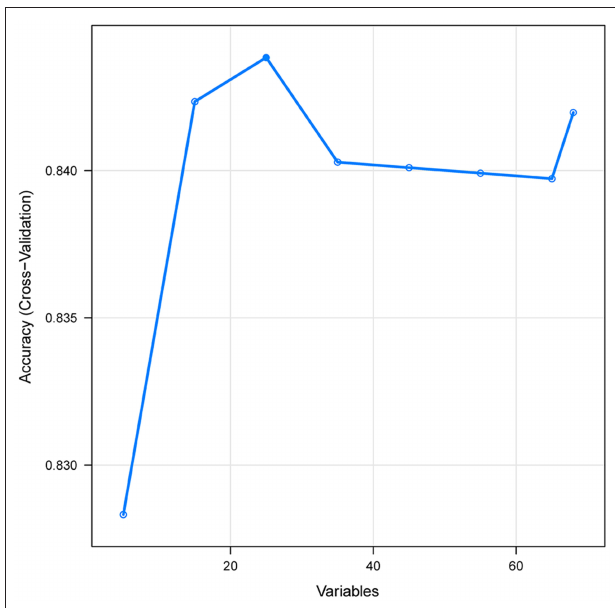
FIGURE 2 | Association between the numbers of variables allowed to be considered at each split and the prediction accuracy in the REF algorithm. REF, recursive feature